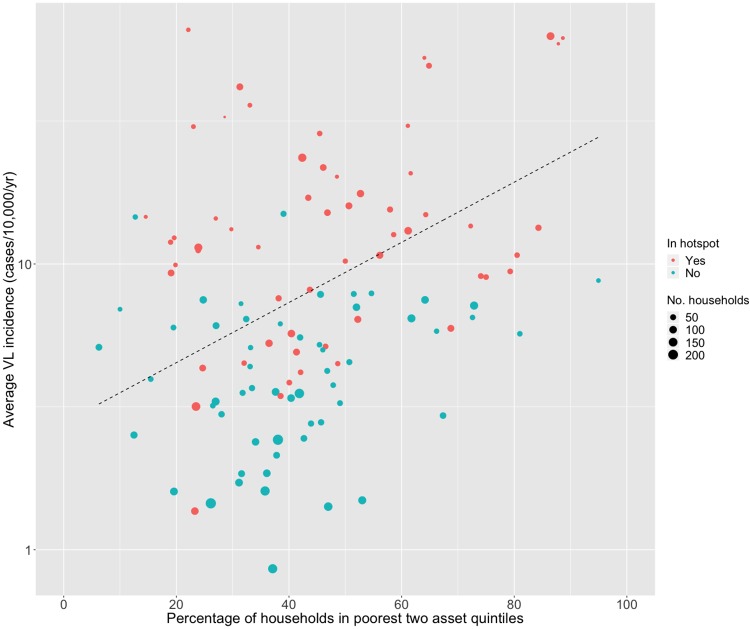
Visceral leishmaniasis (VL) incidence and poverty at the hamlet level.The black dashed line illustrates the Poisson regression line, where 10% more households within the two poorest asset quintiles in a hamlet come with 2.4% increase in annual incidence.